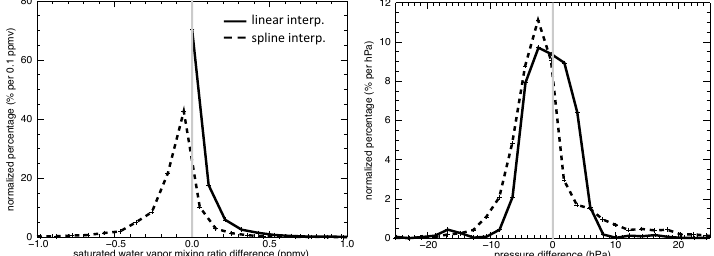
Figure 4. Probability density functions of the differences between linear and cubic spline interpolations from the actual value form the GPS temperature profiles. Left: minimum saturation mixing ratio of the profile (units are percent per 0.1ppmv); right: pressure of the saturation mixing ratio minimum (units are percent per 1hPa). The plus signs in each line mark the bin